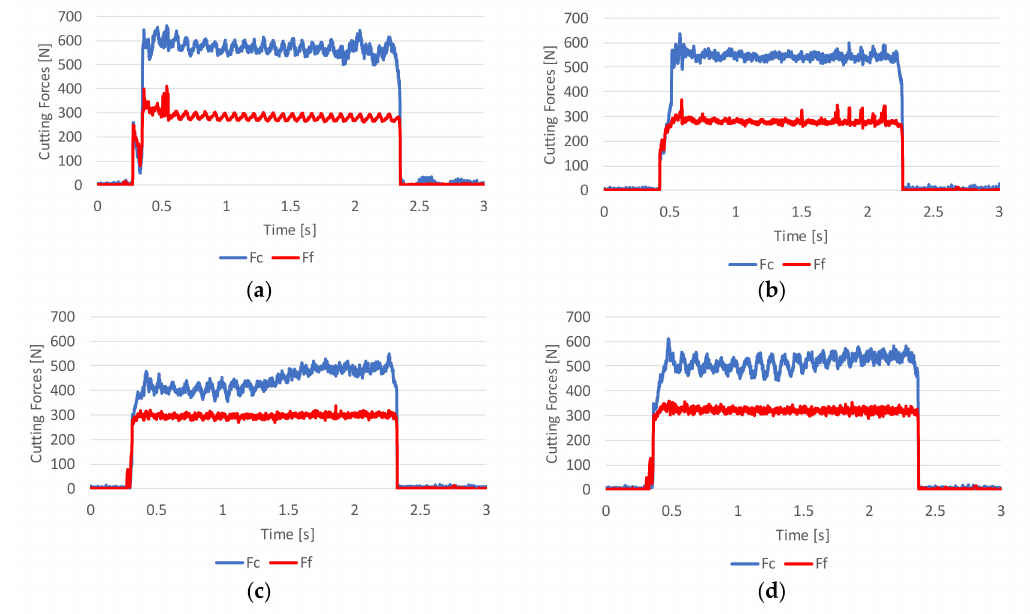
Figure 6. Cutting forces evolution (F c in blue, F f in red) for the tested tubes at a cutting speed of 120 m / min: ( a ) Extruded tube, ( b ) AM tube A, ( c ) AM tube D, ( d ) AM tube